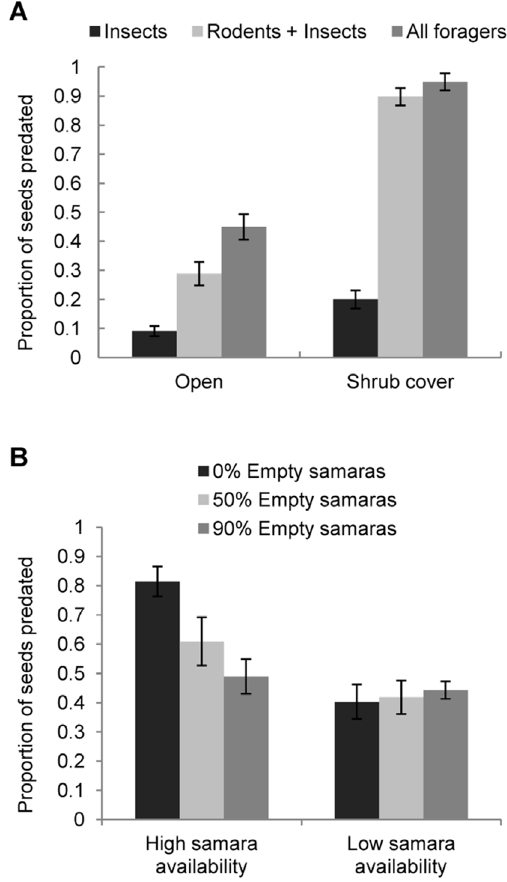
Figure 6. Main interactions found for the proportion of seeds (full samaras) predated on the ground. a) Relationship between microhabitat of samara deposition and guild of foragers; b) Relationship between natural samara availability and proportion of empty samaras. 0% empty samaras means that all samaras were full.